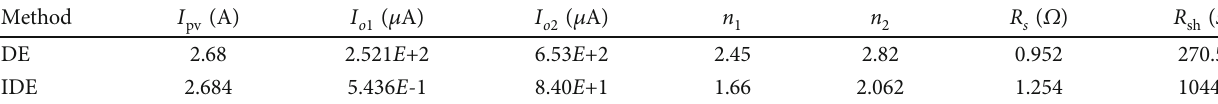
Table 5: Extraction parameters of S25 module with di ff erent methods.